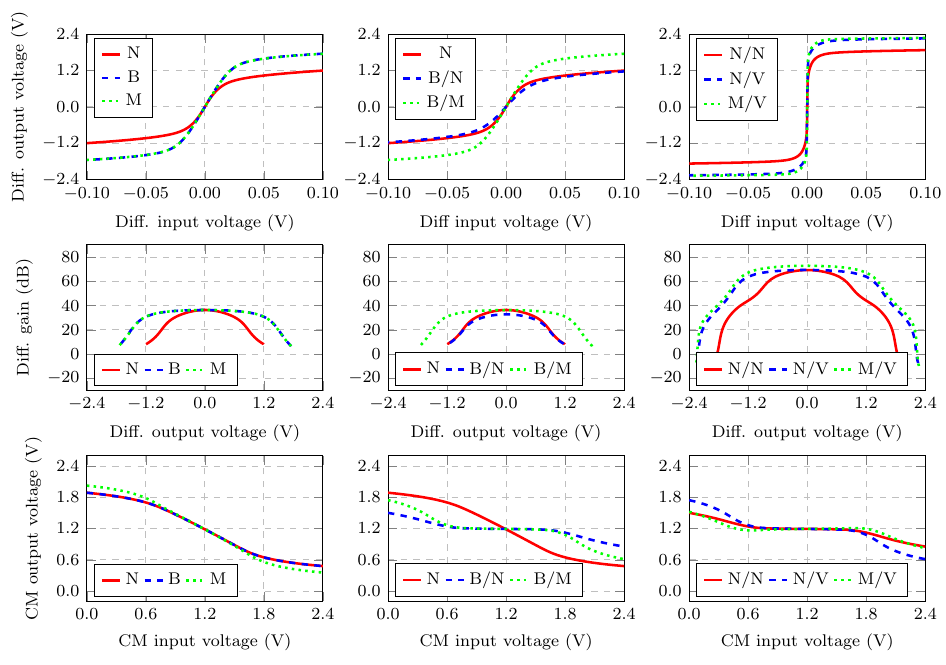
Figure 17. DC simulation